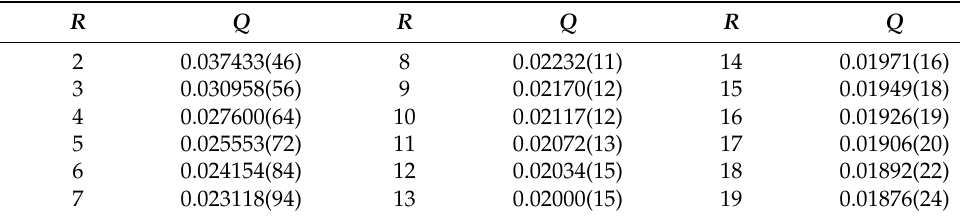
Table 1. Results for Q ( r , T ) , as a function of the interquark distance R , for the (2 + 1) dimensional SU ( 2 ) model at T = 3 T c /4, taken from